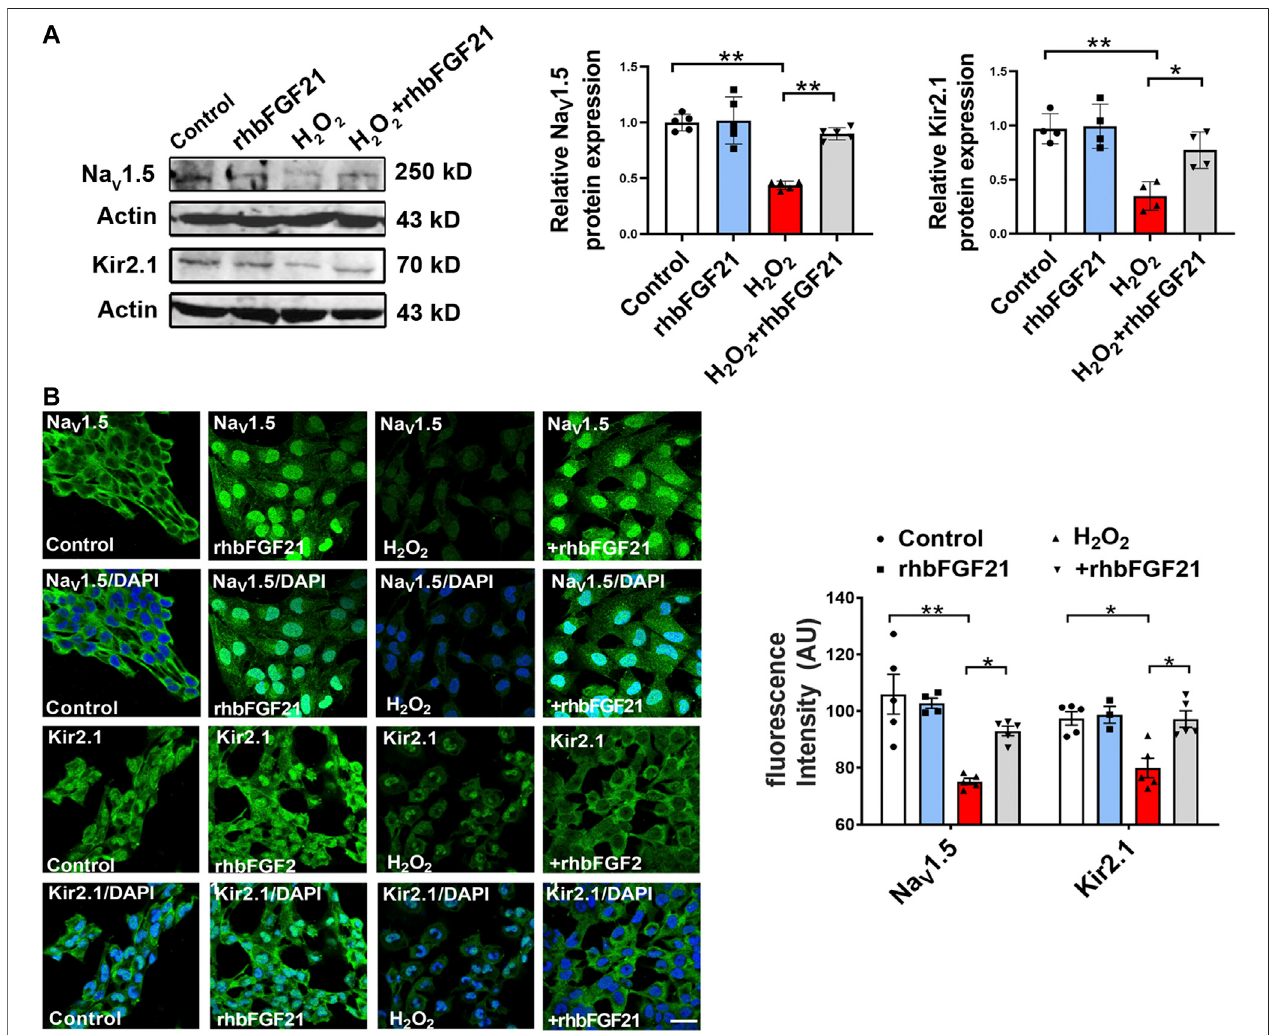
FIGURE 3 | Effects of FGF21 on Na V 1.5 and Kir2.1 expression in human AC16 cells. (A) Protein level of Na V 1.5 and Kir2.1 in AC16 human cardiomyocytes treatment with